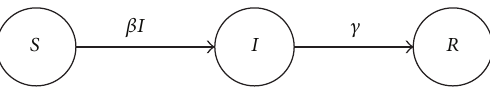
Figure 1: State transition diagram of the KM